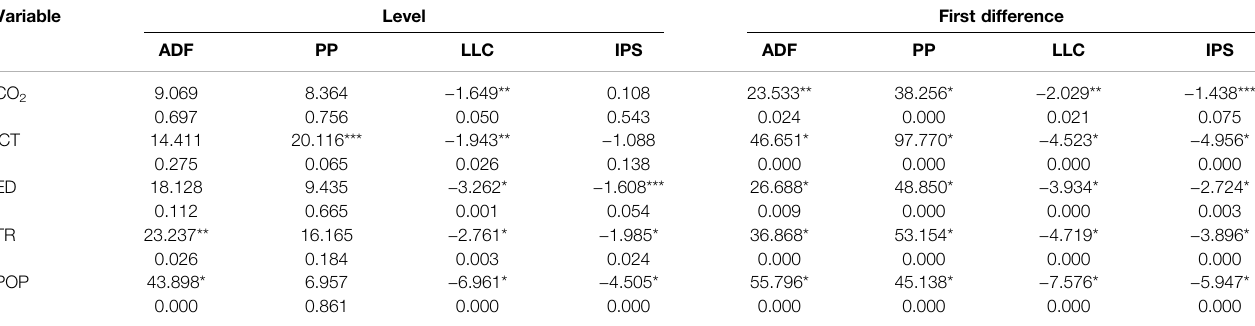
TABLE 2 | Unit root test based on individual intercept variables.